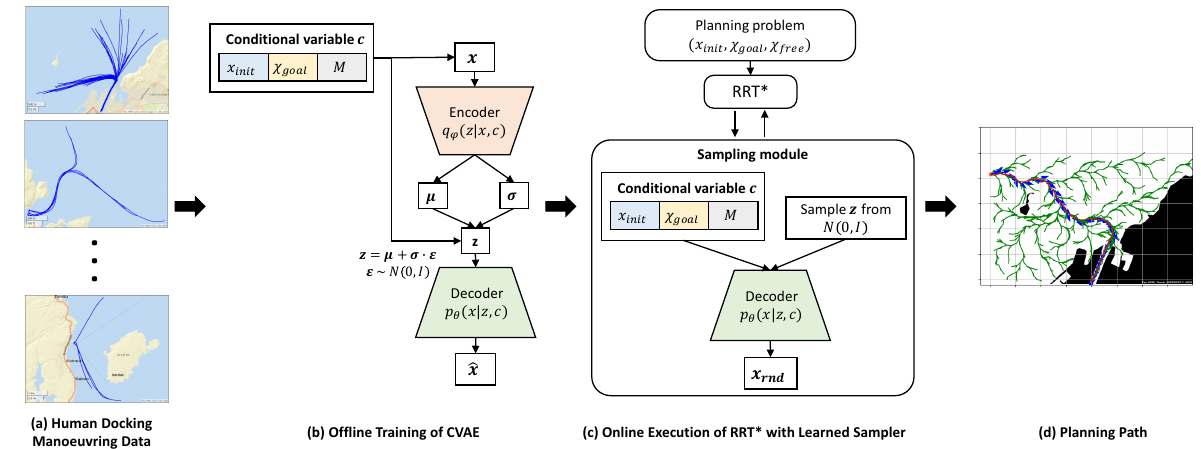
Figure 1: Schematic illustration of the method that leverages human experience in